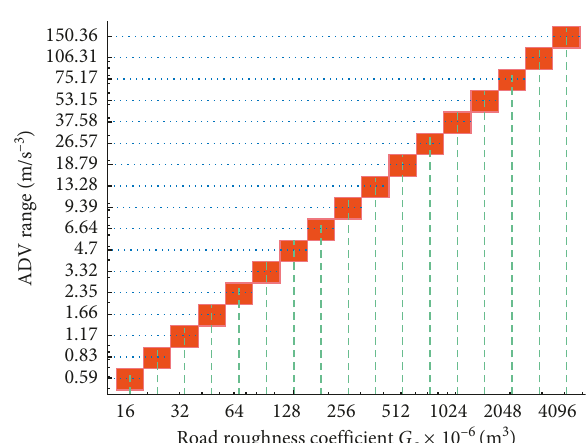
Figure 12: The mapping relationship between road roughness and ADV values.